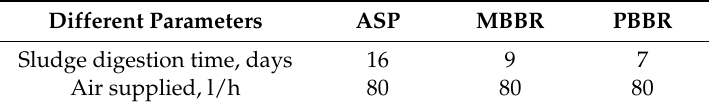
Table 2. Optimum process conditions for a continuous mode sludge digestion system. Different